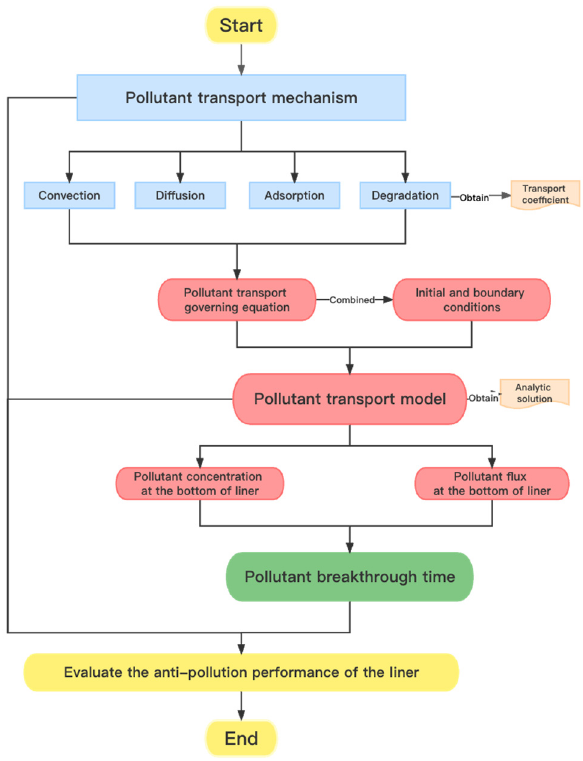
Figure 3. Flow chart of the research process.